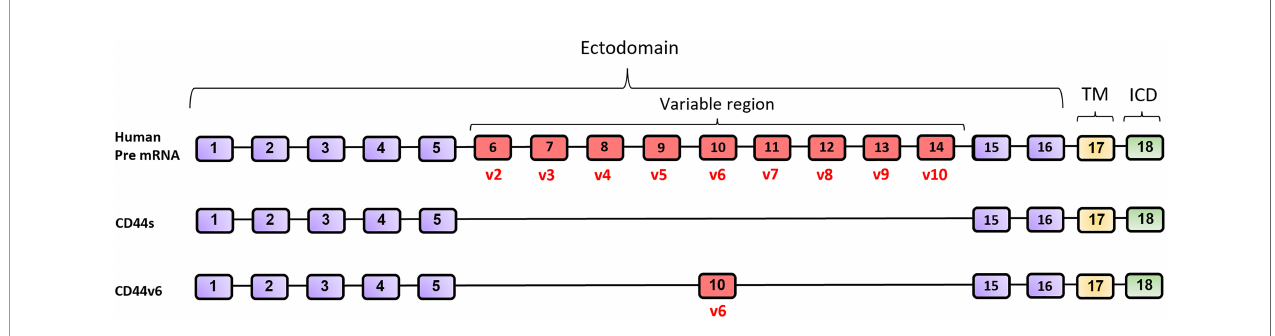
FIGURE 1 | Diagram of full-length CD44 pre-mRNA, CD44s and CD44v6 mRNA in human. CD44 is encoded by 18 exons (ENSEMBL accession number #ENSG00000026508. https://www.ensembl.org/). CD44 isoform 1 (CD44v1) is not present in humans. Exons marked in purple color are always expressed in